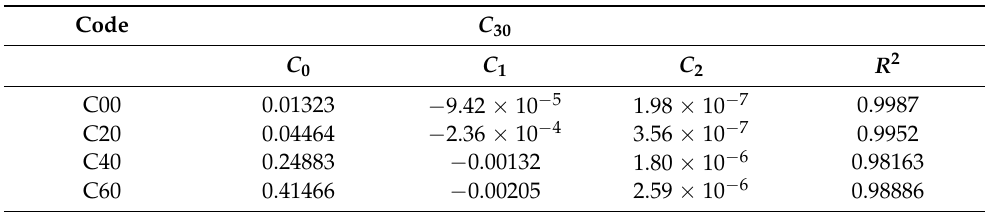
Table 6. Temperature-dependent characterization parameters of the model parameter C 30 for four types of rubbers.